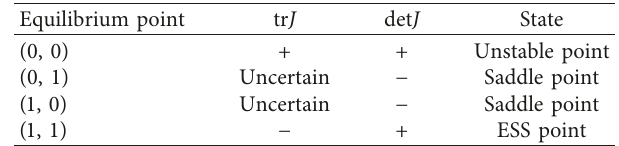
Table 5: Evolutionary stability of local equilibrium points in Scenario IV.